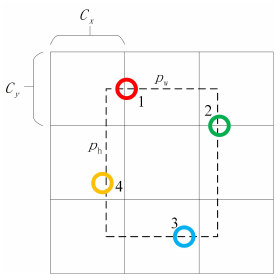
Figure 6. Anchor Points Prediction algorithm in the output